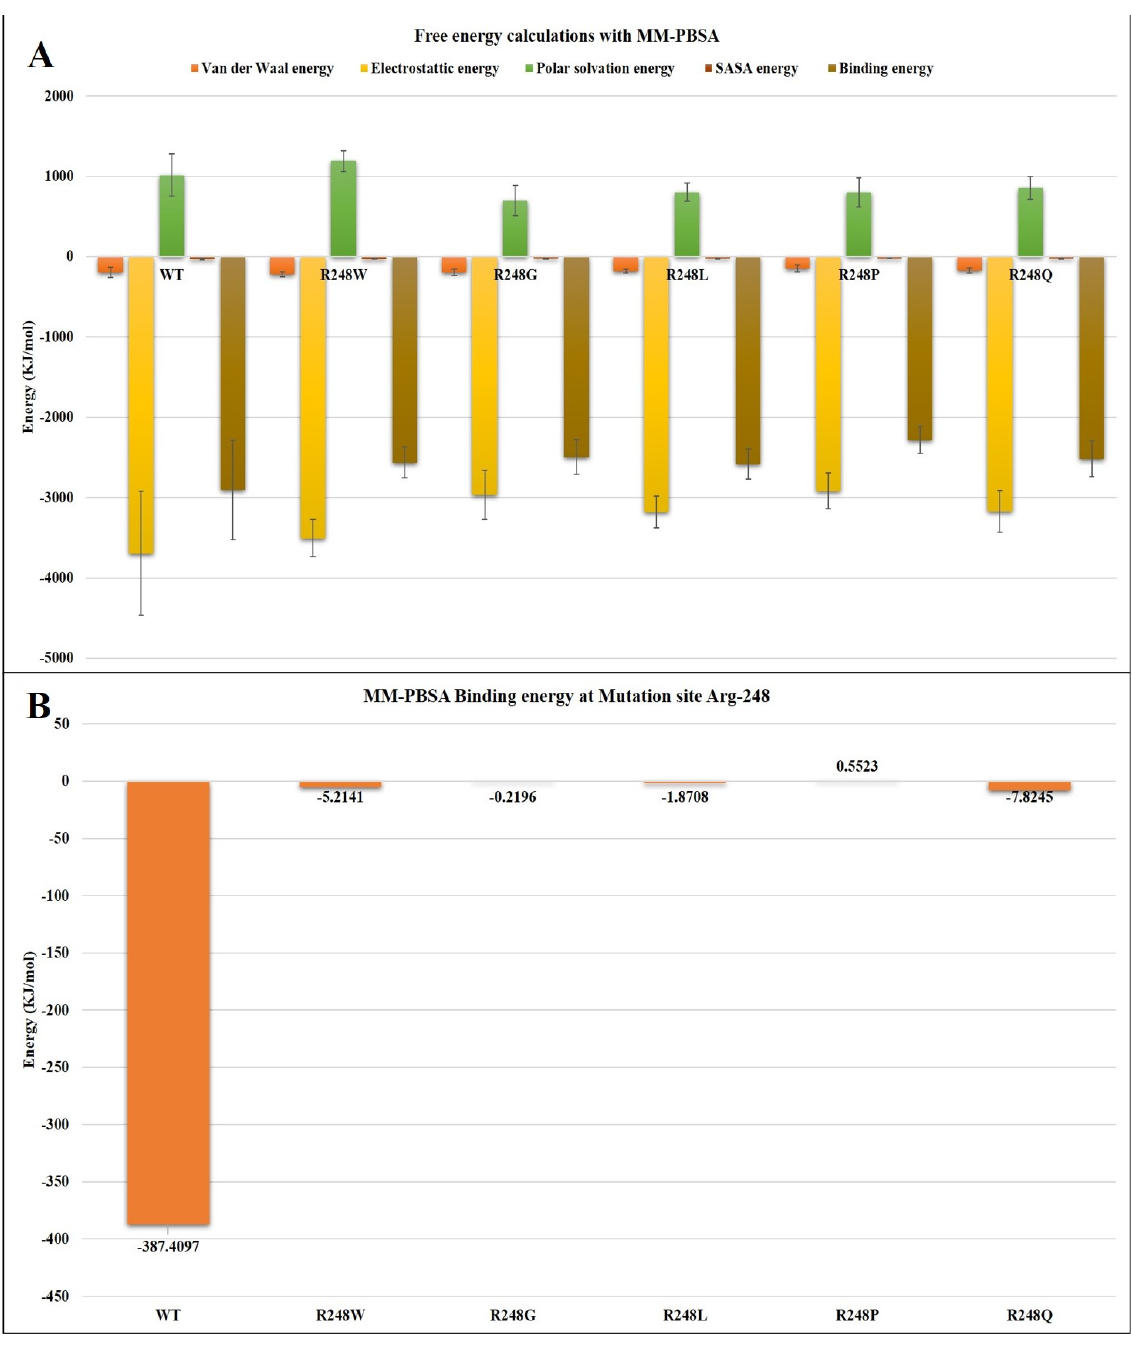
Figure 7. ( A ) Binding free energy with MM-PBSA calculation concerning the overall binding of DNA with wt-p53 and five different R248 mutant-p53 proteins as indicated in the decomposition plot, with a different color for each schematic representation of energy components. ( B ) MM-PBSA decomposition of binding free energy at mutation site Arg-248 was plotted on a per-residue basis with the contributions from electrostatic interactions, vdW energy, polar solvation energy, and SASA energy. Table 4. Conventional H-bonds formed between the p53 protein amino acid Arg248 and DNA in different mutations.